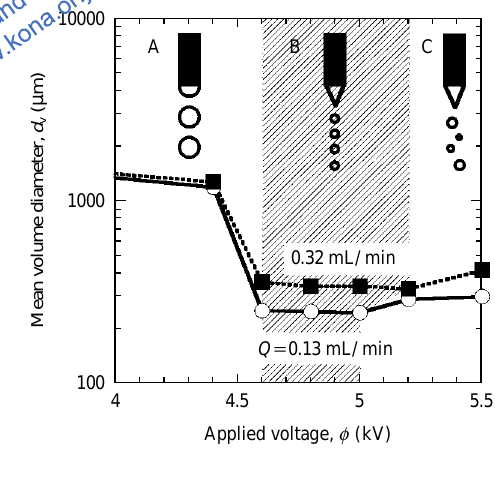
Effect of Applied Voltage on Mean Volume Diameter A: Dripping mode B: Uniform cone-jet mode C: Discharge